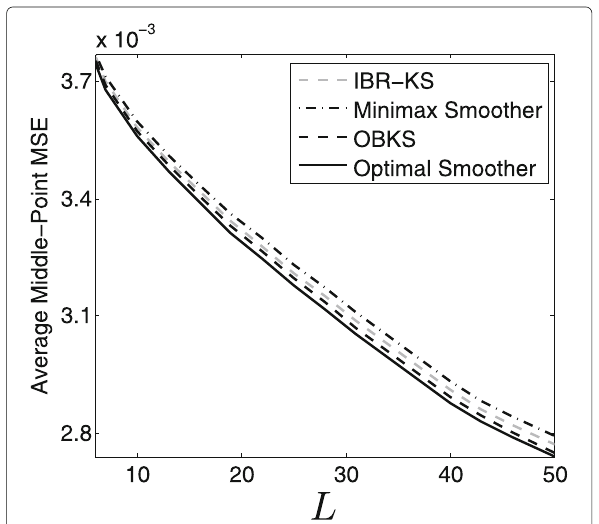
Fig. 13 Average middle-point MSE of different smoothing approaches for different observation window length L for the network inference example with unknown